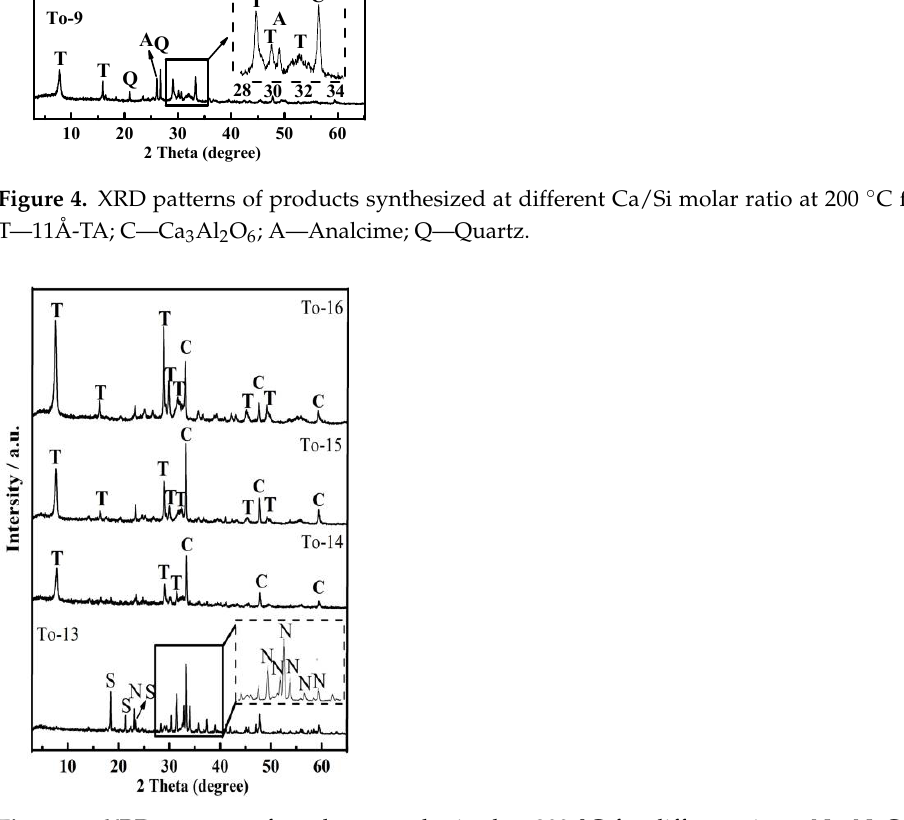
Figure 5. XRD patterns of products synthesized at 200 ◦ C for different time. N—NaCaHSiO 4 ; S—Sodium Calcium Aluminum Oxide Silicate Hydrate; T—11Å-TA; C—Ca 3 Al 2 O 6